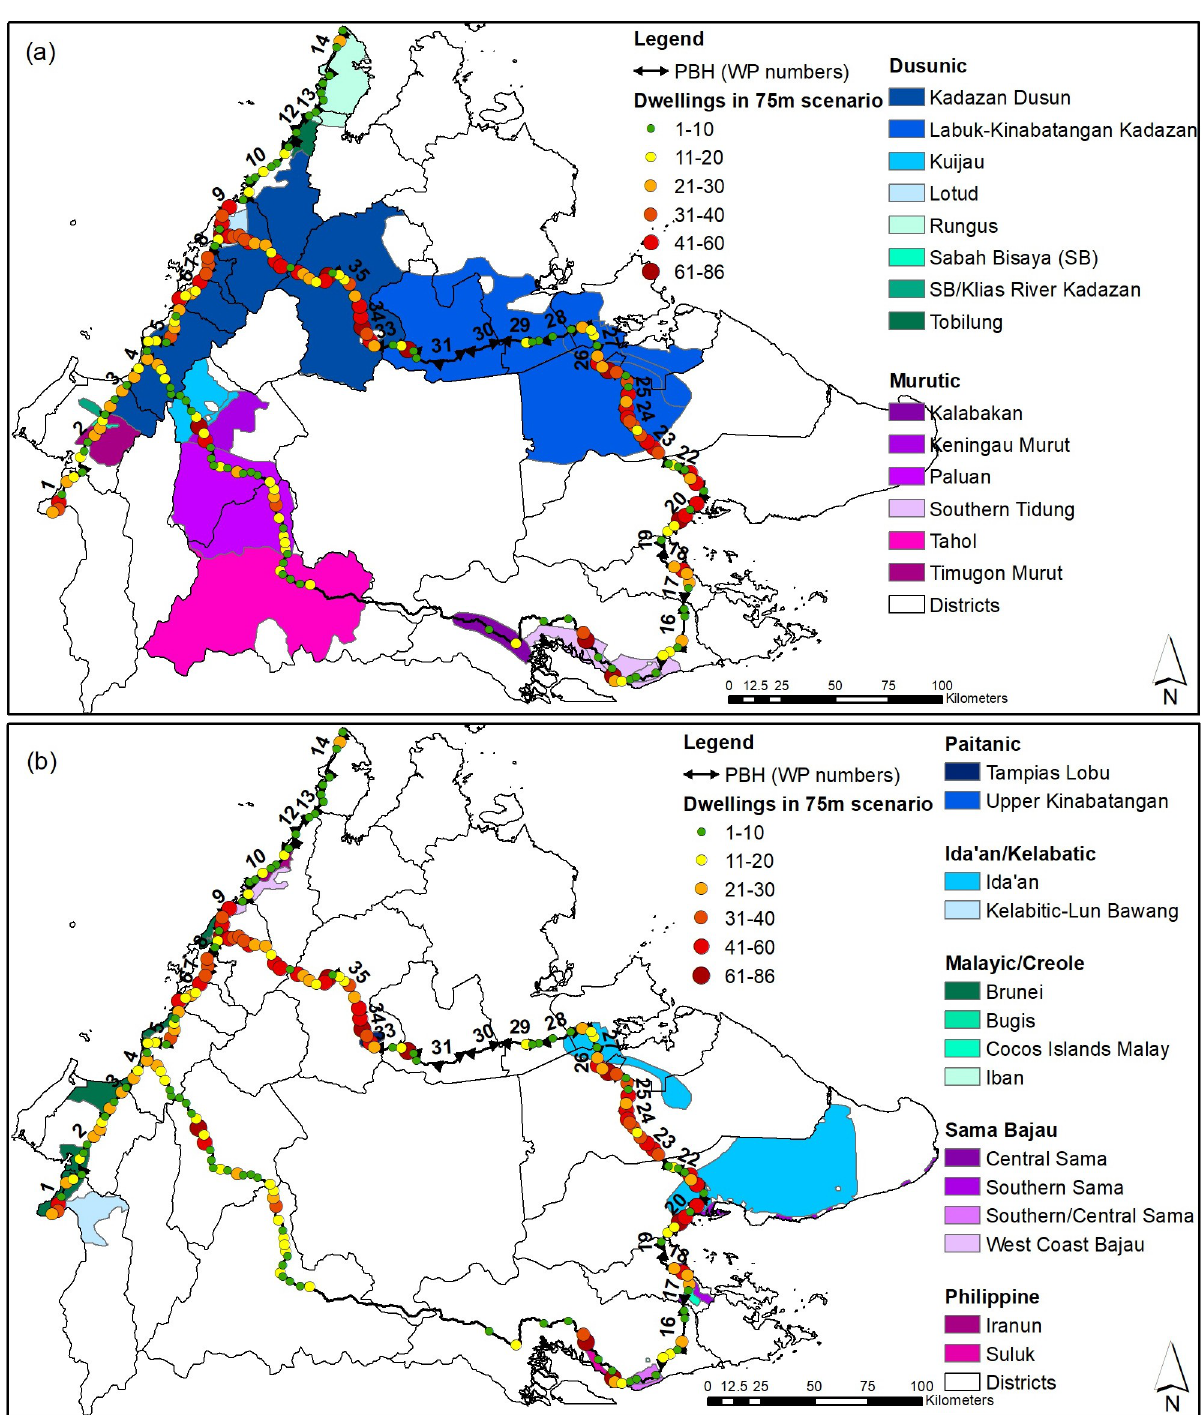
Fig 2. Impacted dwellings of the Pan Borneo Highway and traditional Indigenous territories. Maps showing the digitised alignment of the Pan Borneo Highway (PBH) (black line) in Sabah, along with the number of dwellings (coloured dots) that would be demolished within the 75m width scenario of the PBH; along with the geographic regions of the various Dusunic and Murutic languages (a), and Paitanic, Ida’an, Kelabatic, Malayic, Creole, Sama Bajau and Philippine languages (b), which indicate those ethnic groups that may be impacted by the PBH. The linguistic data is adapted and republished from Lewis et al. (2016) under a CC BY license, with permission from SIL International, original copyright (2016).